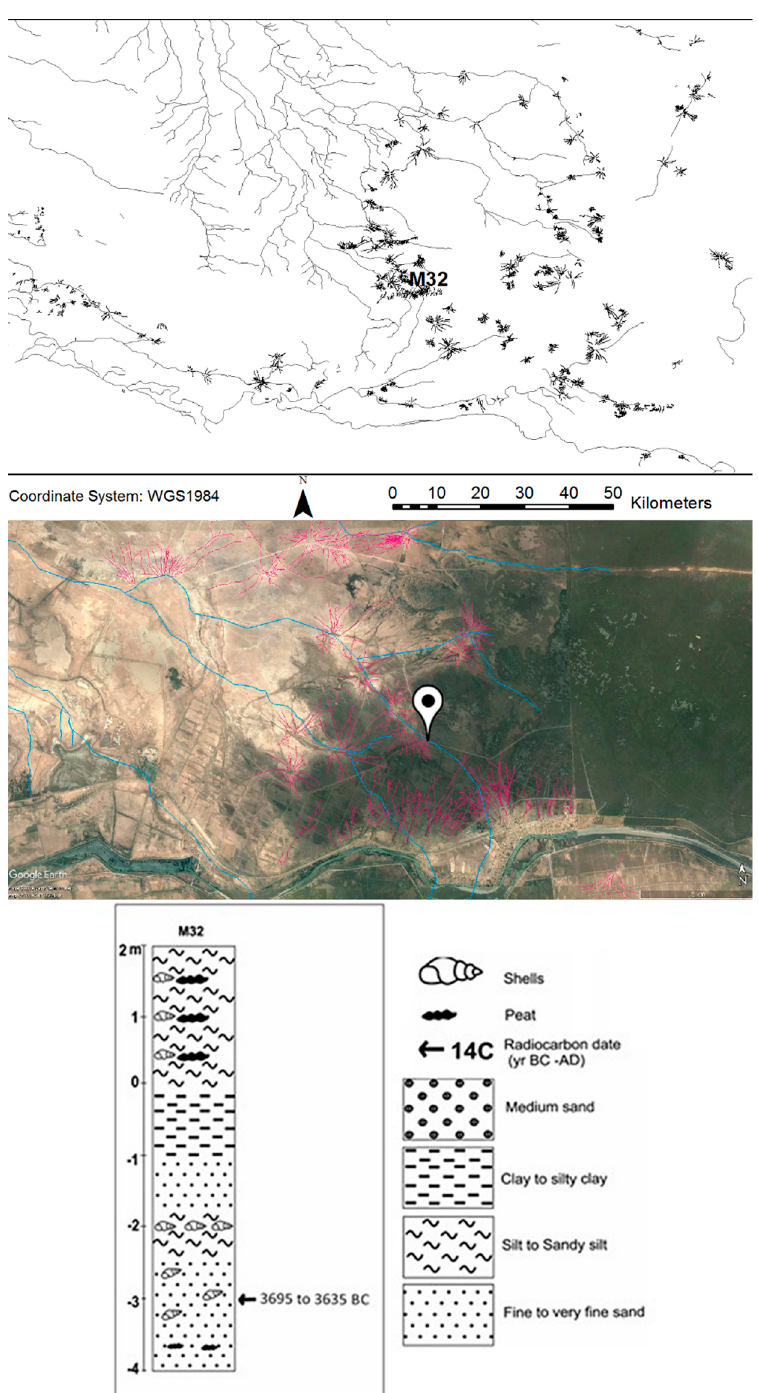
Figure 15. The ages of the hollow ways in Southern Mesopotamia were mainly determined through dating by association with sites, but in one instance, three undocumented sites with hollow ways were located along a channel that had been radiocarbon dated from a shell recovered in a borehole (M32) to the mid-fourth millennium BC.